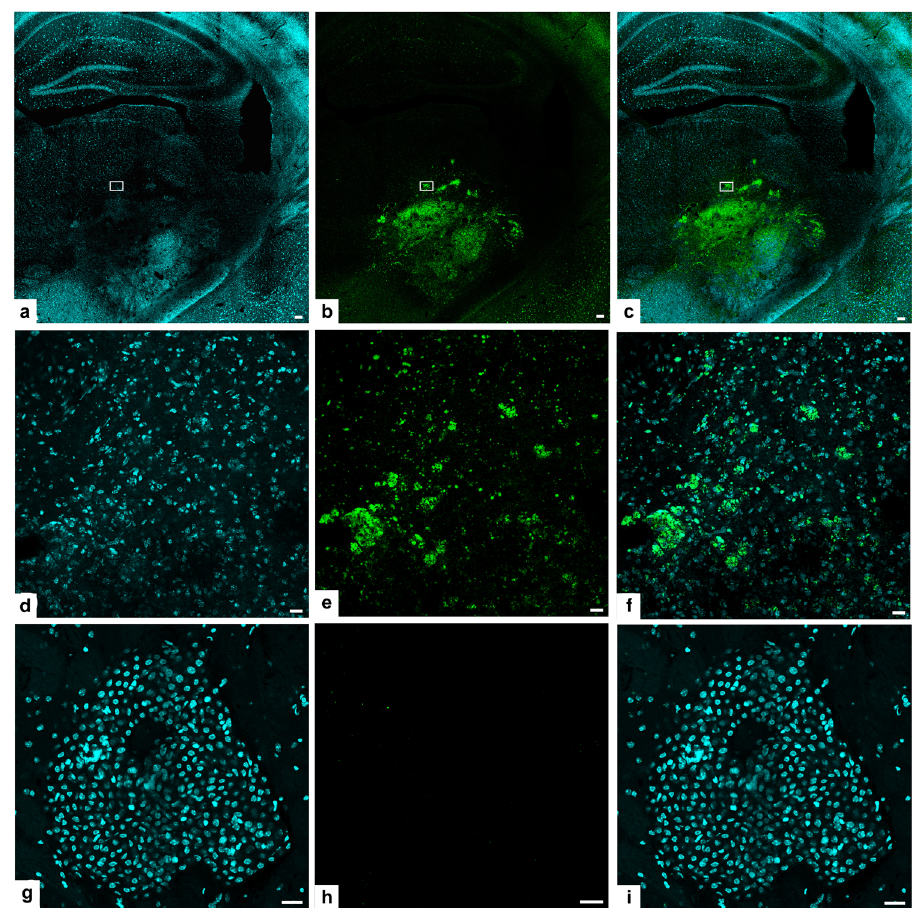
Fig. 8 In vivo labeling by the fl uorescent ALDH1A3 substrates of GL261 cells growing and in fi ltrating the host brain 6 days after the initial inoculum. a – f Confocal images showing the same coronal section of a tumor-bearing brain in an animal. injected i.p. with Probe 10 for 6 h. In all images the area boxed is the same and it is shown at higher magni fi cation in d – f . In a cell nuclei are stained by DAPI, in 6b, GL261 cells containing Probe 10 fl uorescence in green. Most of the fl uorescence comes from glioma cells growing in the left striatum and adjacent structures that have taken up and metabolized Probe 10 . Scale bars: 25 μ M. In 6c, the image shows the double fl uorescence of DAPI and Probe 10 together. d – f show confocal images showing at higher magni fi cation the area boxed in 6a – c. Fluorescence of Probe 10 is mostly contained in the cytoplasm. Scale bars: 25 μ M. g – h Confocal images showing, under different fl uorescence conditions, the same coronal section of a tumor-bearing brain in an animal i.p. injected with compound Probe 11 that does not penetrate to any appreciable level the tumor cells in vivo, despite penetrating GL261 cells in vitro. Scale bars: 25 μ M. i Confocal image under excitation and fi ltering conditions appropriate both for DAPI and Probe 11 , no fl uorescence due to Probe 11 is visible despite the abundance of tumor